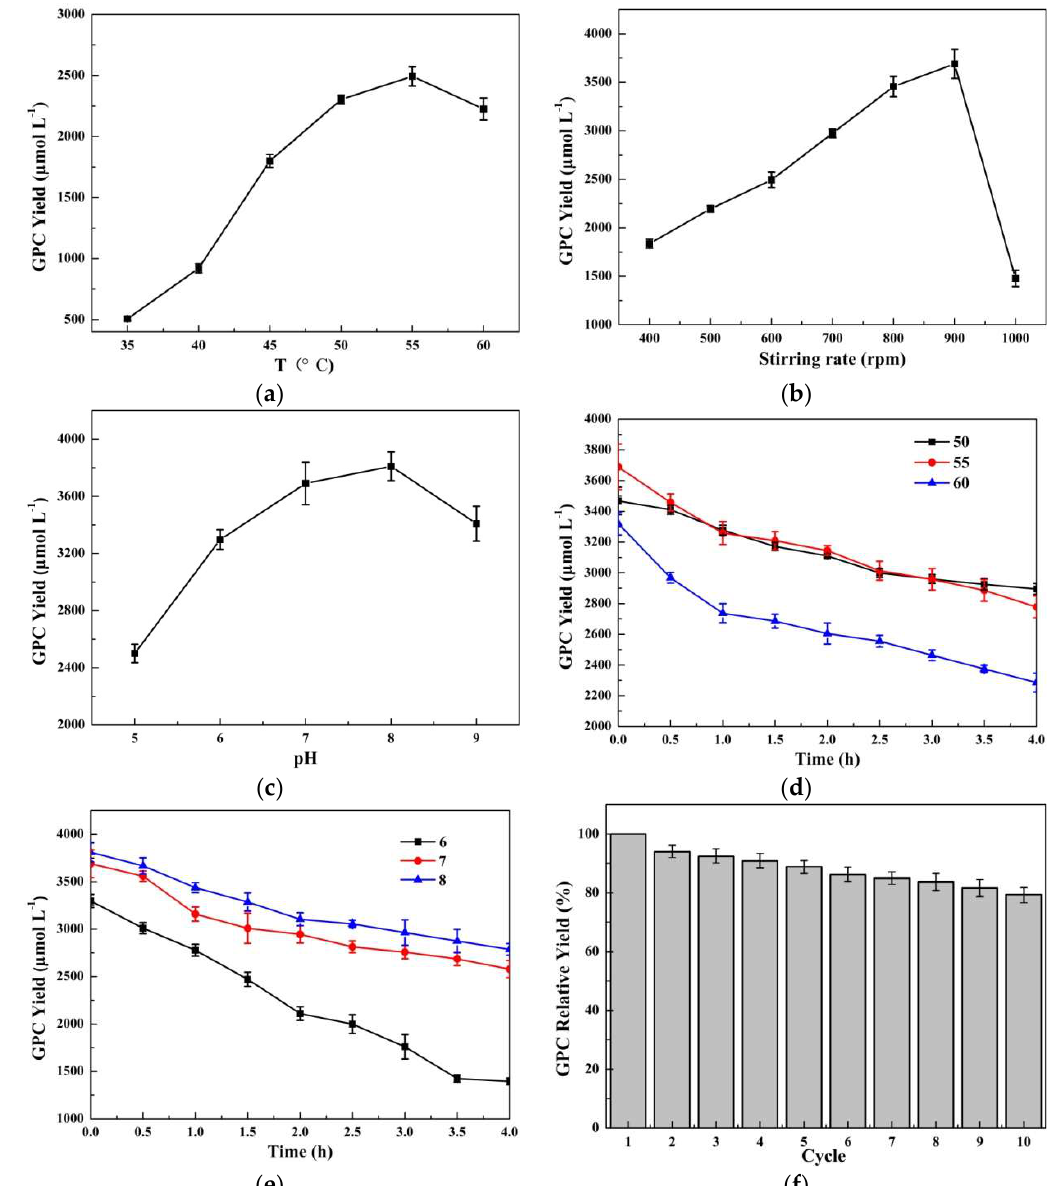
Figure 4. ( a ) The effect of temperature on the yield of L-α-GPC catalyzed by 2-Melm@PLA 1 /MSNC; ( b ) the effect of stirring rate on the yield of L-α-GPC catalyzed by 2-Melm@PLA 1 /MSNC; ( c ) the effect of pH on the yield of L-α-GPC catalyzed by 2-Melm@PLA 1 /MSNC; ( d ) the thermal stability of 2-Melm@PLA 1 /MSNC on the yield of L-α-GPC; ( e ) the pH stability of 2-Melm@PLA 1 /MSNC on the yield of L-α-GPC; ( f ) the reusability of 2-Melm@PLA 1 /MSNC on the yield of L-α-GPC.